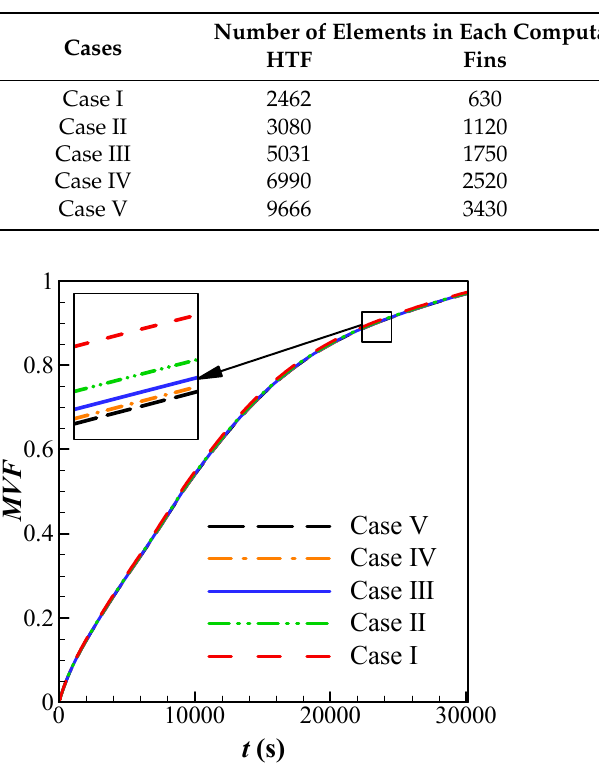
Table 3. The details of investigated meshes when Al 2 O 3 , AR = 0.95, α = 0.25 π , and VF na = 0.03.